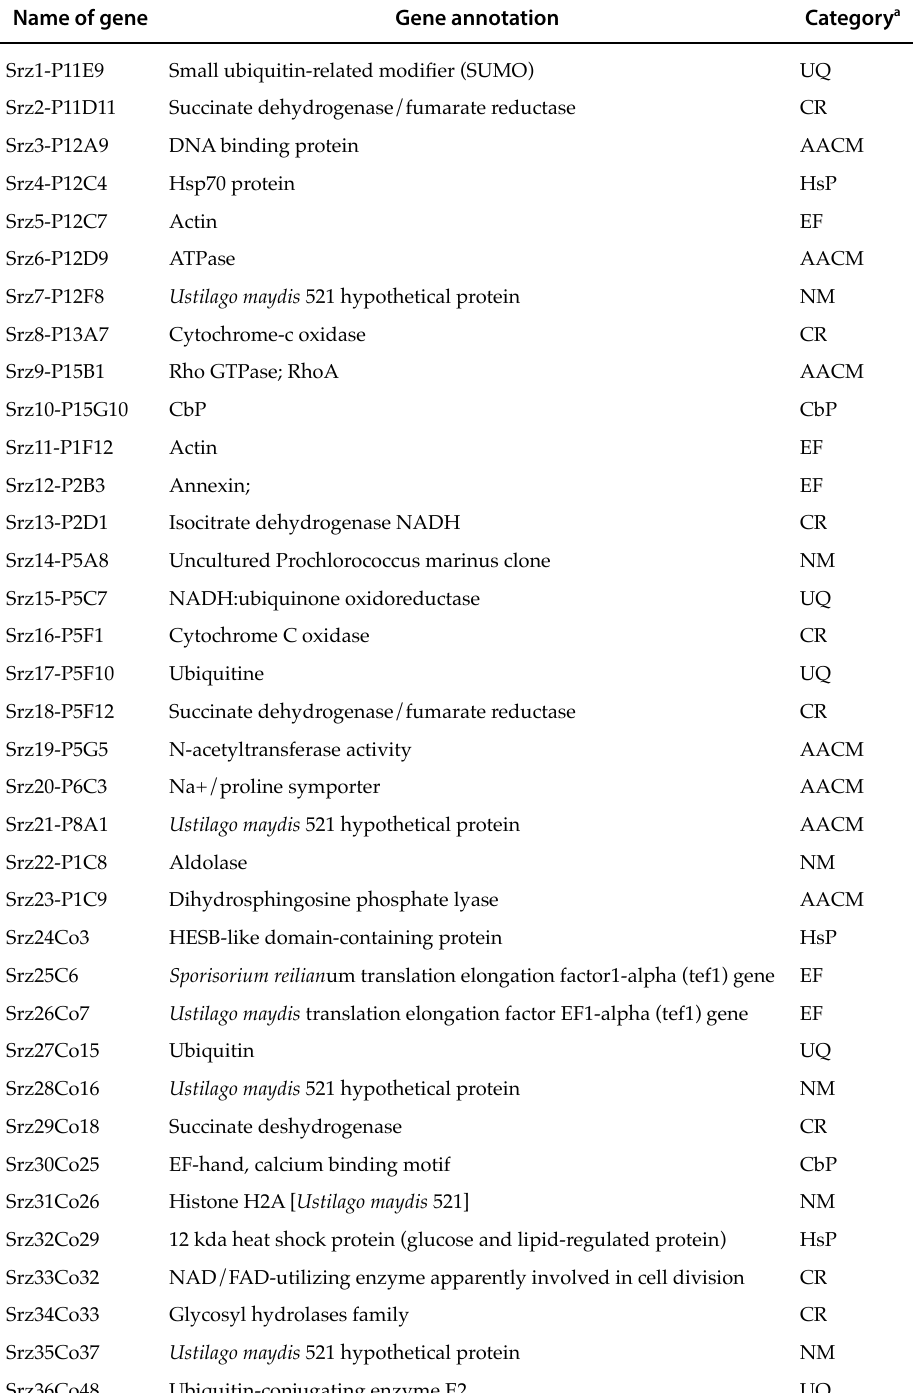
Table 1. Gene annotation for 36 candidate genes issuing from Macroarray